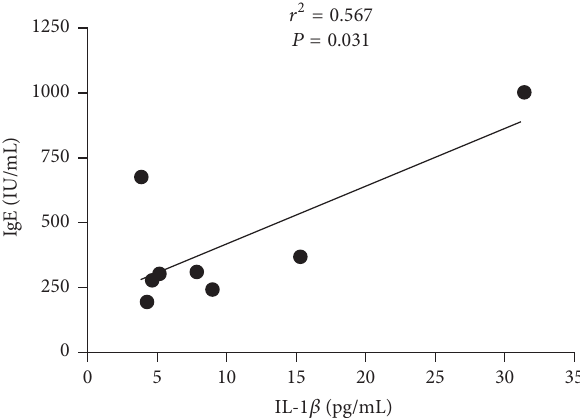
Figure 3: Association between IL-6 and IgE for RF+IgE+ SLE patients.